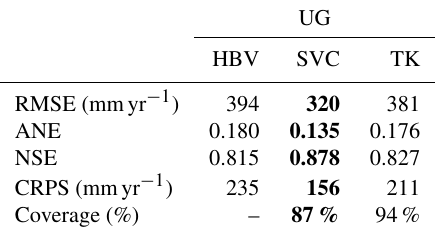
Table A1. Predictive performance for cross-validation when the tar- get catchments are treated as ungauged (UG) for the HBV model, the suggested SVC model, and for Top-Kriging (TK). Short records are omitted from the observation likelihood and the preprocessing step is not performed. The best method for each evaluation criterion is marked in